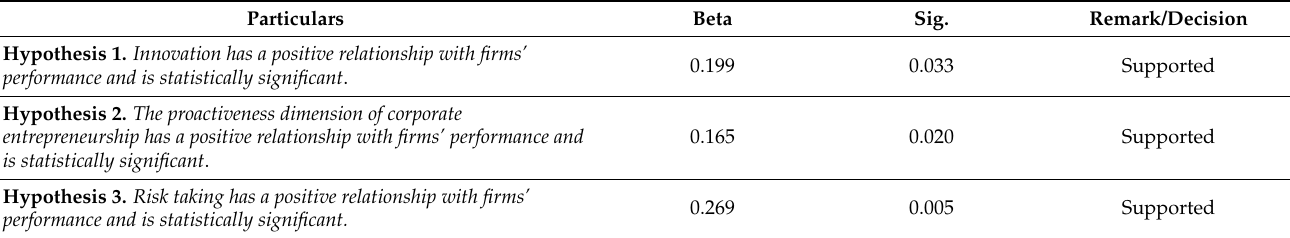
Table 12. Hypothesis